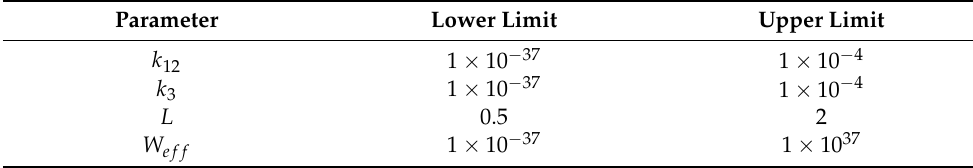
Table 1. Limits used in the parameter determination.